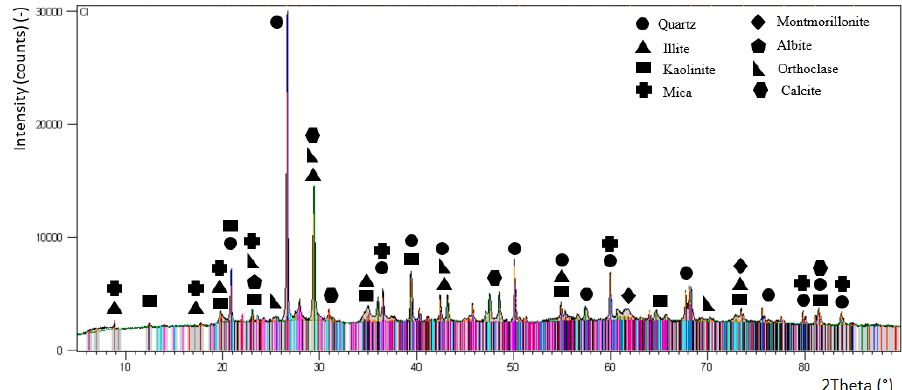
Figure 3. The granulation curve of soil from Central Europe (Brno, CZ), XRD analysis of clay soil ‘Cl’.